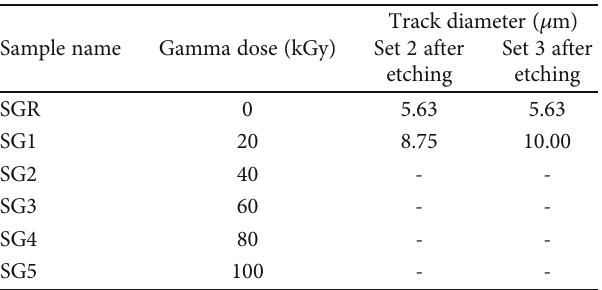
Table 5: Variation of track diameters at di ff erent gamma doses of chemically etched